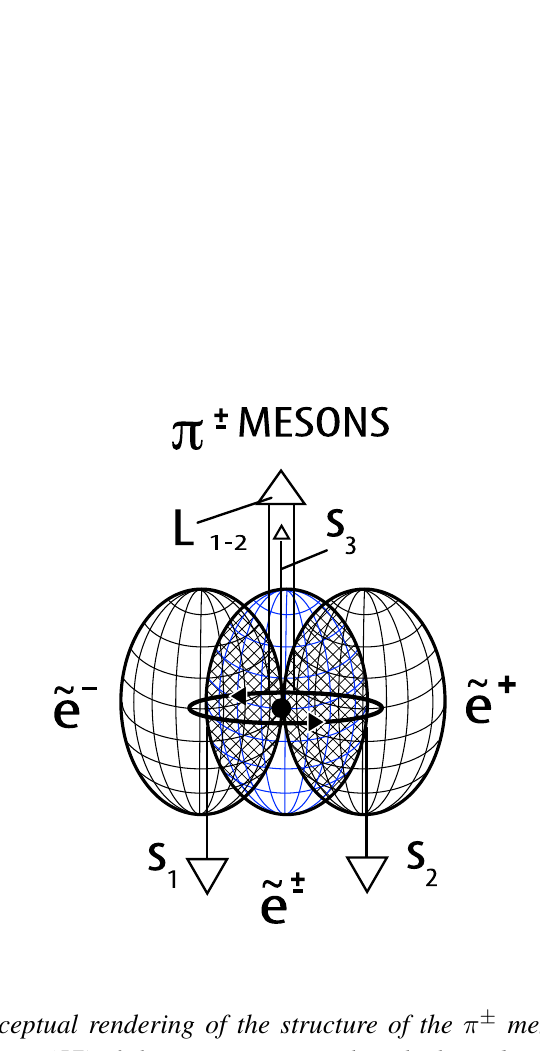
Figure 8: A conceptual rendering of the structure of the π ± mesons as a three-body hadronic bound states (57) of elementary isoparticles which can be interpreted as a “com- pressed µ ± lepton” (Figure 6). Note that individual pairs of isoconstituents are coupled in singlet as necessary for consistency. Note also that the isoconstituents have a point-like charge structure. Therefore, the charge diameter of the structure is given by the distance between the centers of the two peripheral